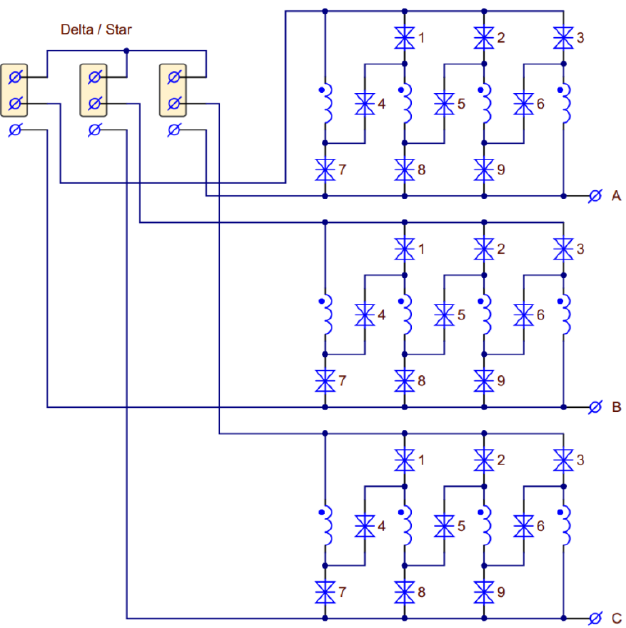
Figure 5. General scheme of the electronic switch windings. For the purpose of switching among winding schemes jumpers have been used. These commutation elements do switch the 12-stator windings among each other to obtain six working circuits with different parameters, shown in Figure 6 Error! Reference source not found. . The higher the inductance of the switched scheme, the higher the torque of the BLDC motor and the lower its speed. Each connection scheme of the stator windings has its own dynamic range, effective operating speed, and current consumption.